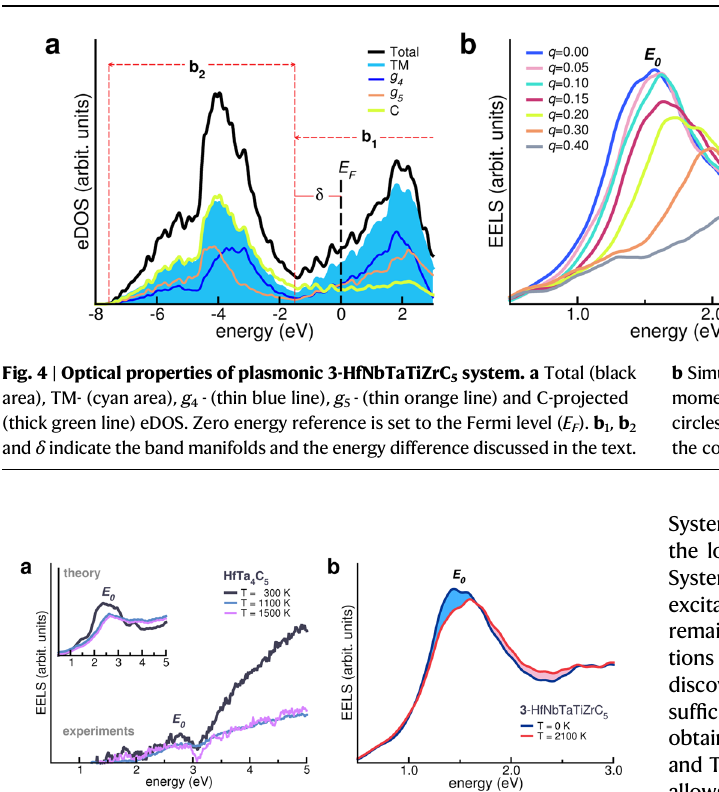
Fig. 5 | Thermalevolutionofplasmonic properties.a ExperimentalEELS spectra of HfTa 4 C 5 as a function of temperature. Inset reports the corresponding theore- tical spectra, evaluated at the same temperatures. b Simulated EELS spectra of 3 - HfNbTaTiZrC 5 at different temperatures. Source data are provided as a Source Data fi